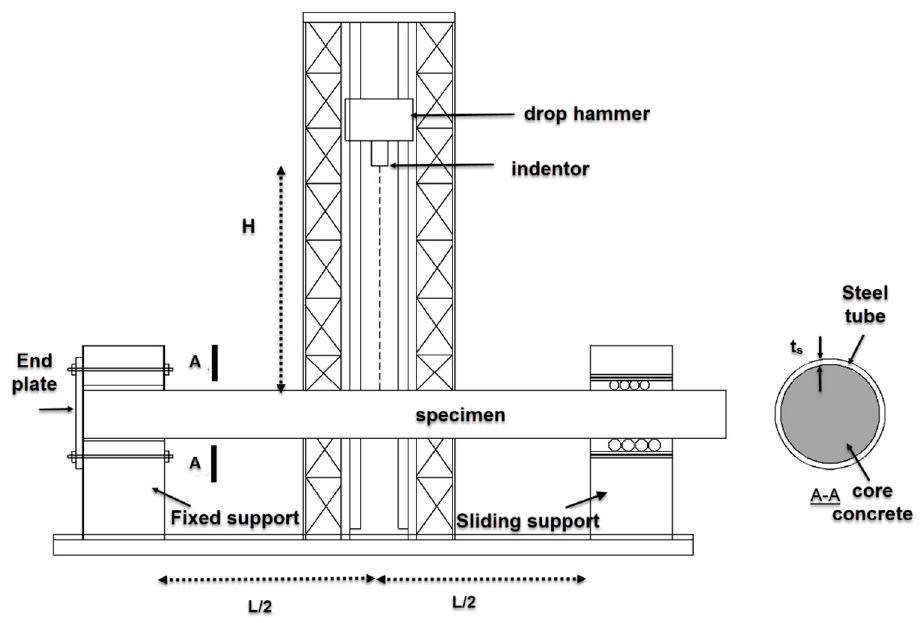
Figure 3. Test setup .